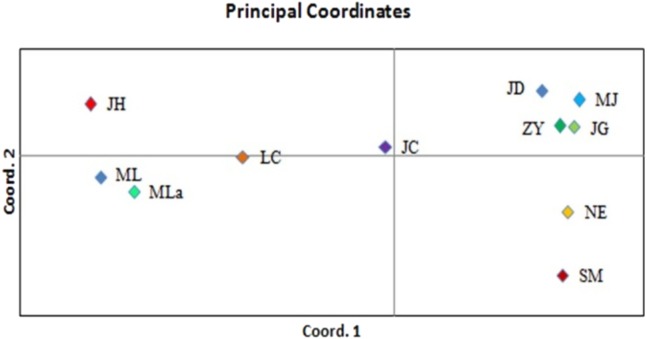
PCoA of 11 populations based on variability.